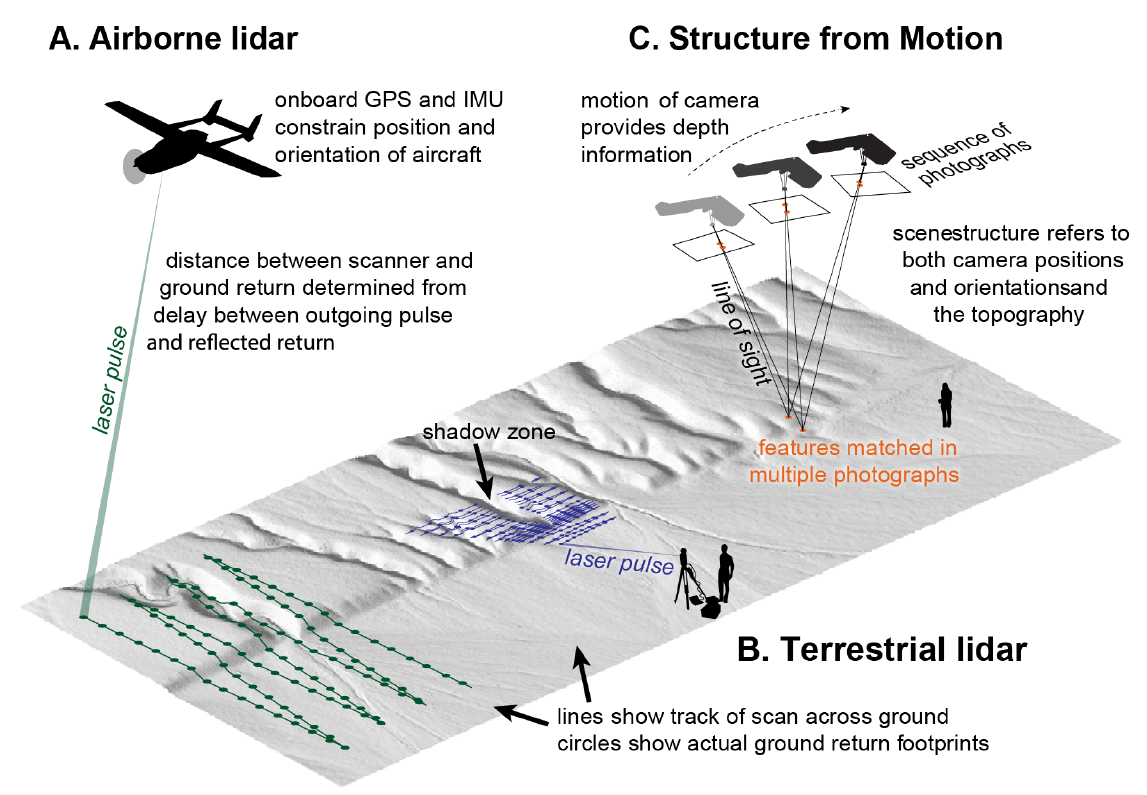
Figure 14. A schematic illustration of three methods of producing high-resolution digital topography: A . Airborne lidar (light detection and ranging), B . Terrestrial lidar, C . UAS-based structure from Motion (GPS—global positioning system; IMU—inertial measurement unit), modified from Johnson et al. [72]. An overview of the strengths and weaknesses of different algorithms used for multi-image SfM is discussed by Smith et al. [62] and Oliensis [73]; however, most commercially available software packages for this purpose utilize procedures optimized for high accuracy and